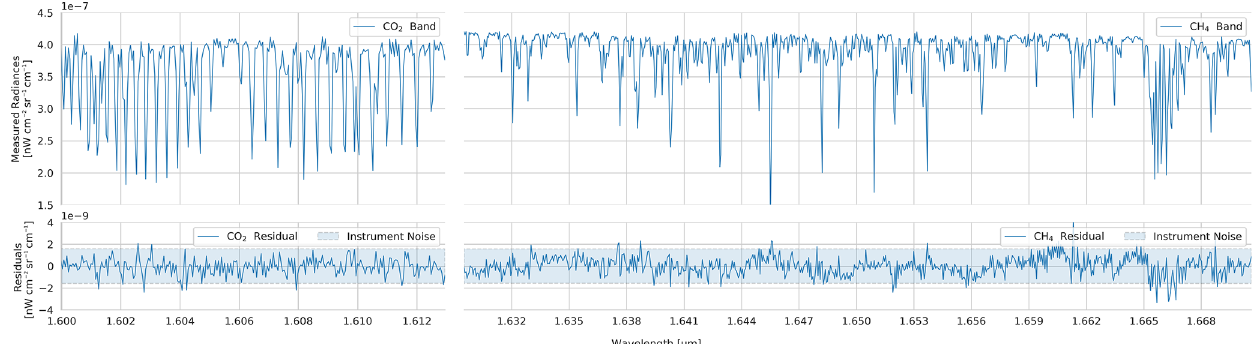
Figure 2. Spectra showing the GOSAT radiances for the CO 2 and CH 4 bands and the resulting residuals (measured − simulated spectral differences). The data shown are the median values for the 25274 land retrievals that pass the quality filtering for an example month, August 2016.